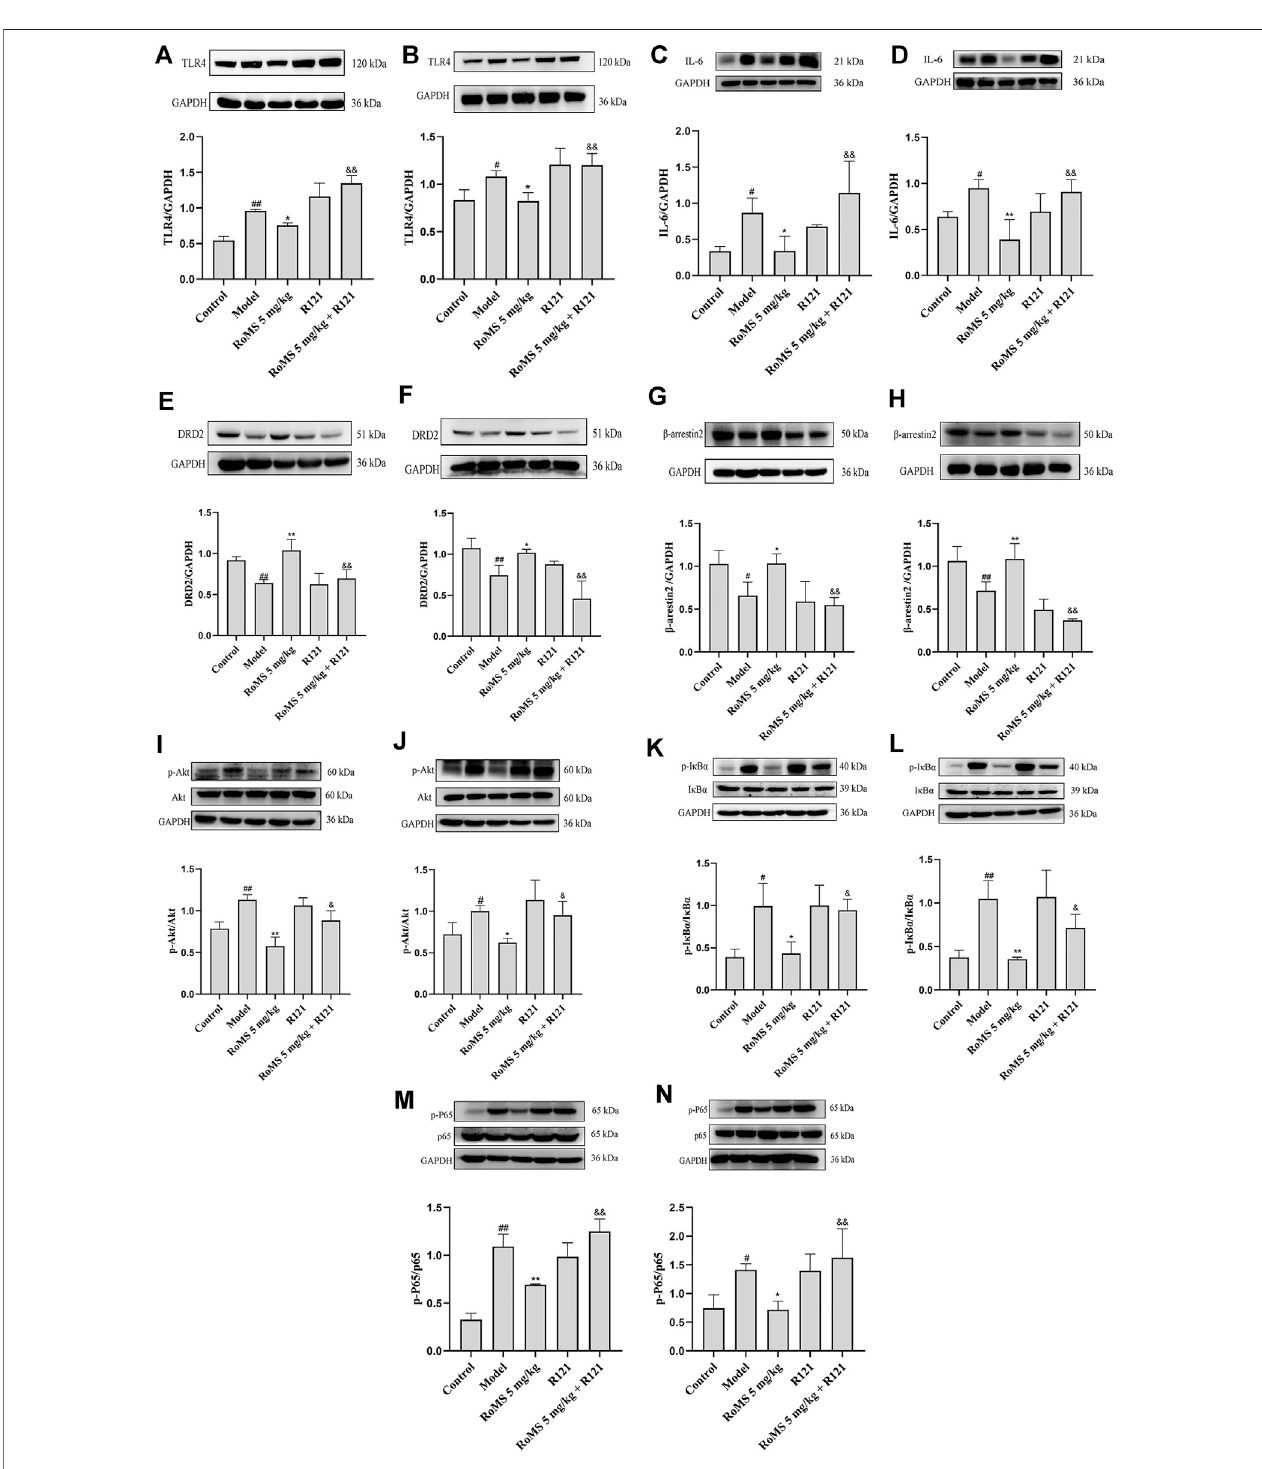
FIGURE 6 | Effects of RoMS on the Akt/NF- κ B pathway related proteins in the liver of mice. At 3 d and 7 days after RoMS pre-administration, the levels of TLR4 (A,B) , IL-6 (C,D) , DRD2 (E,F) , β -arrestin 2 (G,H) , p-Akt/Akt (I,J) , p-I κ B α /I κ B α (K,L) , p-P65/p65 (M,N) . The data are expressed as the mean ± SD (n = 3 in each group). # p < 0.05 or ## p < 0.01 versus control group, * p < 0.05 or ** p < 0.01 versus model group, & p < 0.05 or && p < 0.01 versus RoMS 5 mg/kg group.